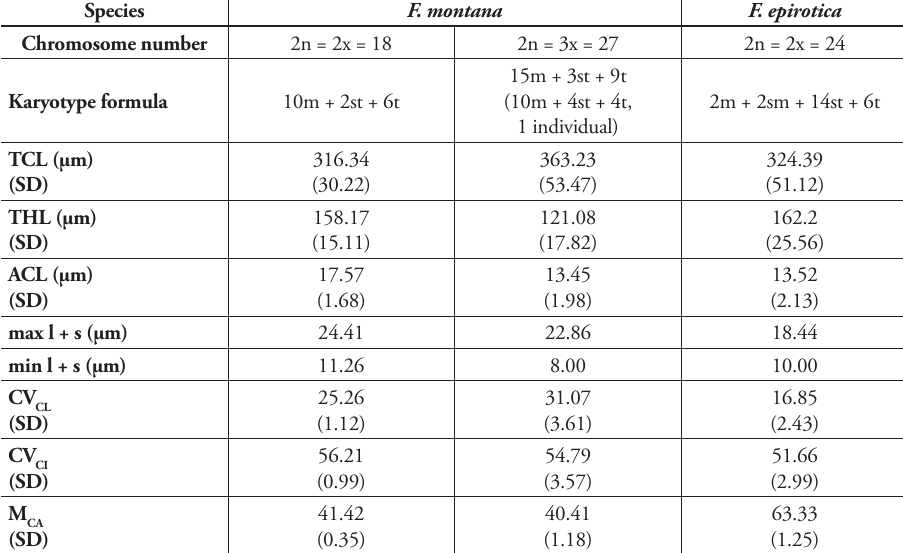
Table 2. Studied species with karyomorphometric indices. Chromosome number (2n), total (TCL) and average (ACL) chromosome length, total haploid chromosome length (THL), maximum (max l + s) and minimum (min l + s) chromosome length, karyotype asymmetry indices (CV Species F.